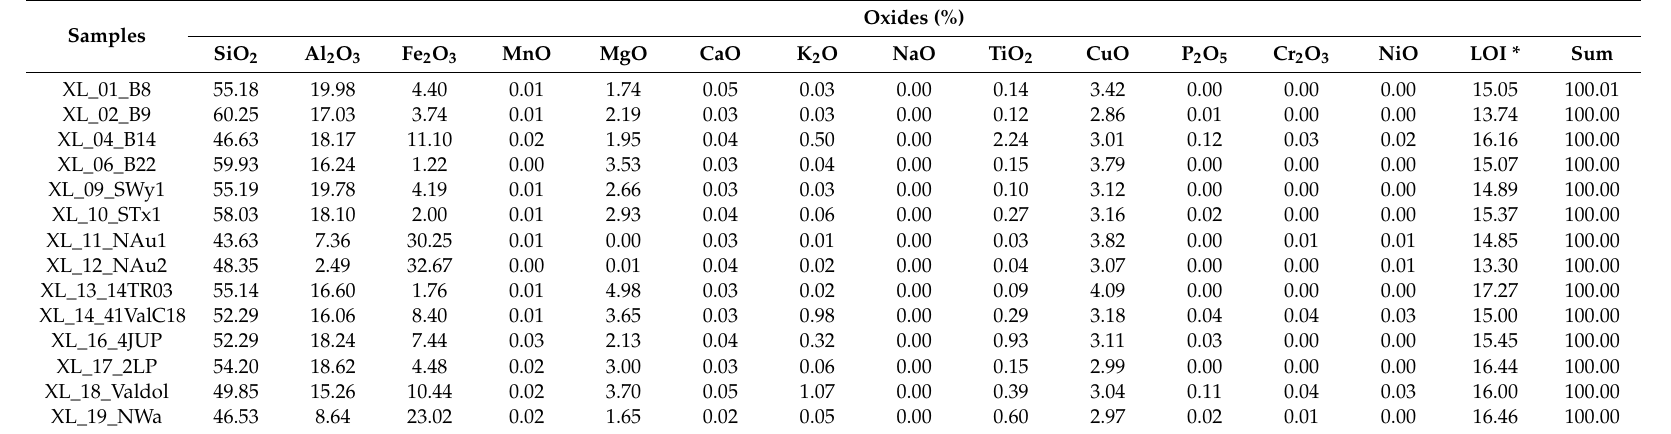
Table 2. Chemical compositions of samples measured by XRF analysis ( < 0.2 µ m